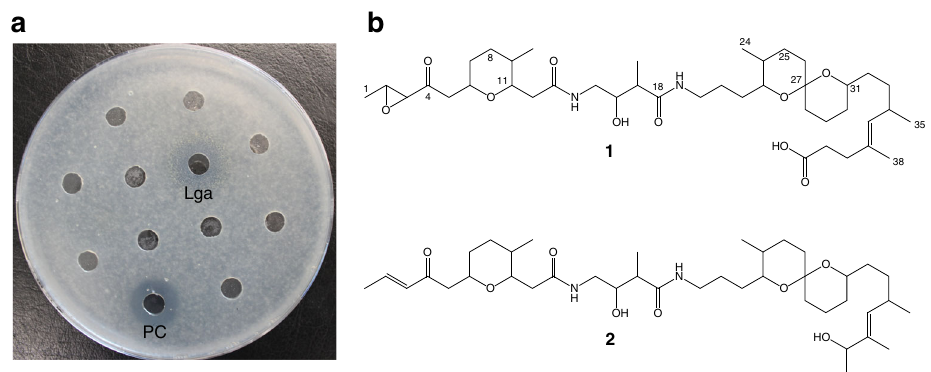
Fig. 2 The antifungal polyketide lagriamide is present on the eggs of fi eld-collected Lagria villosa beetles. a Bioassay of fractions from L. villosa egg extracts showing antifungal activity against Aspergillus niger by the lagriamide-containing fraction (Lga) and nystatin (50 µ g mL − 1 ) as positive control (PC). b Chemical structures of lagriamide ( 1 ) and bistramide A ( 2 ) 78